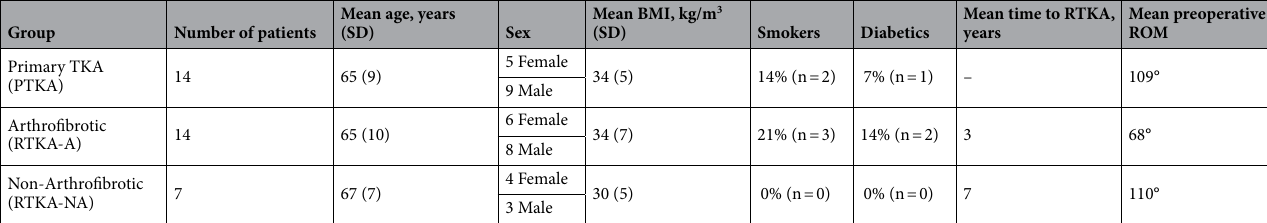
Table 1. Patient demographics for each group including primary TKA (PTKA), revision TKA for arthrofibrosis (RTKA-A) and revision TKA for non-arthrofibrotic etiologies (RTKA-NA). Age is represented in years at time of surgery. BMI = body mass index, ROM = range of